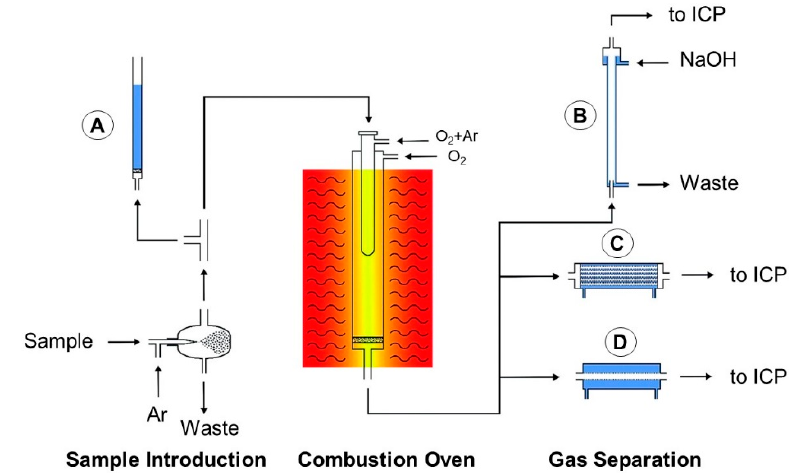
Figure 7. Experimental setup of the online combustion system: ( A ) overpressure safety section, ( B ) falling ‐ film glass ‐ tube column, ( C ) hollow fiber gas device, ( D ) commercial desolvation device. Reproduced from reference [103], published under the license CC BY 3.0.